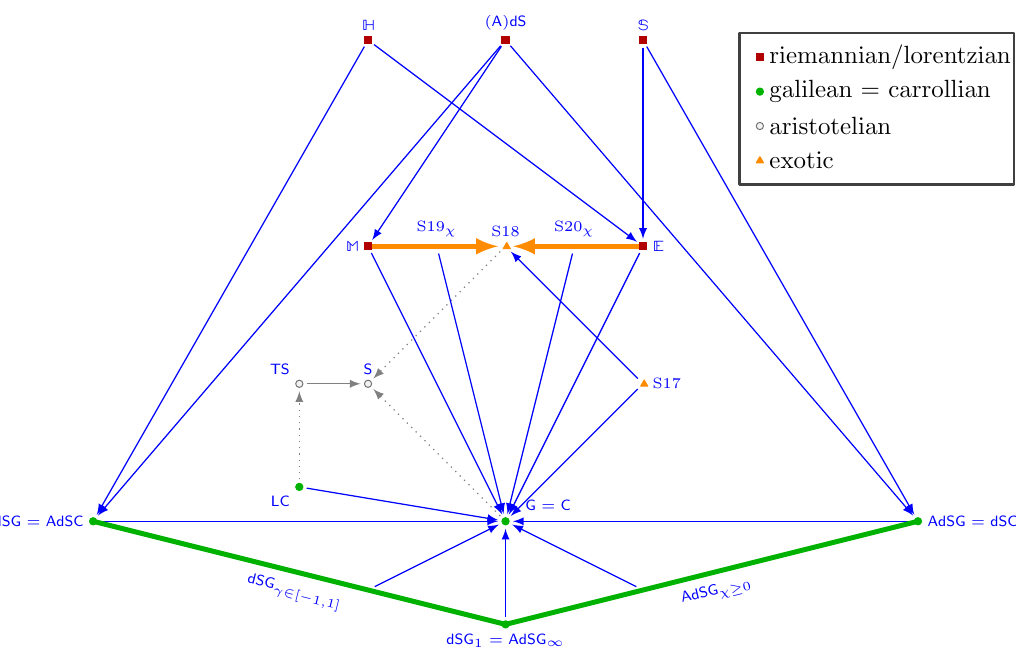
Figure 3 . Two-dimensional homogeneous spacetimes and their